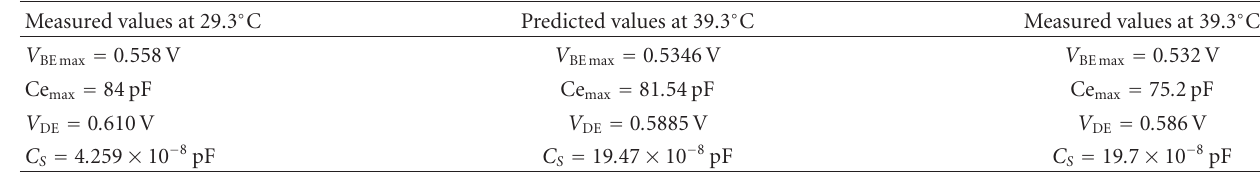
Table 1: Values measured and predicted with the new model. Measured values at 29.3 ◦